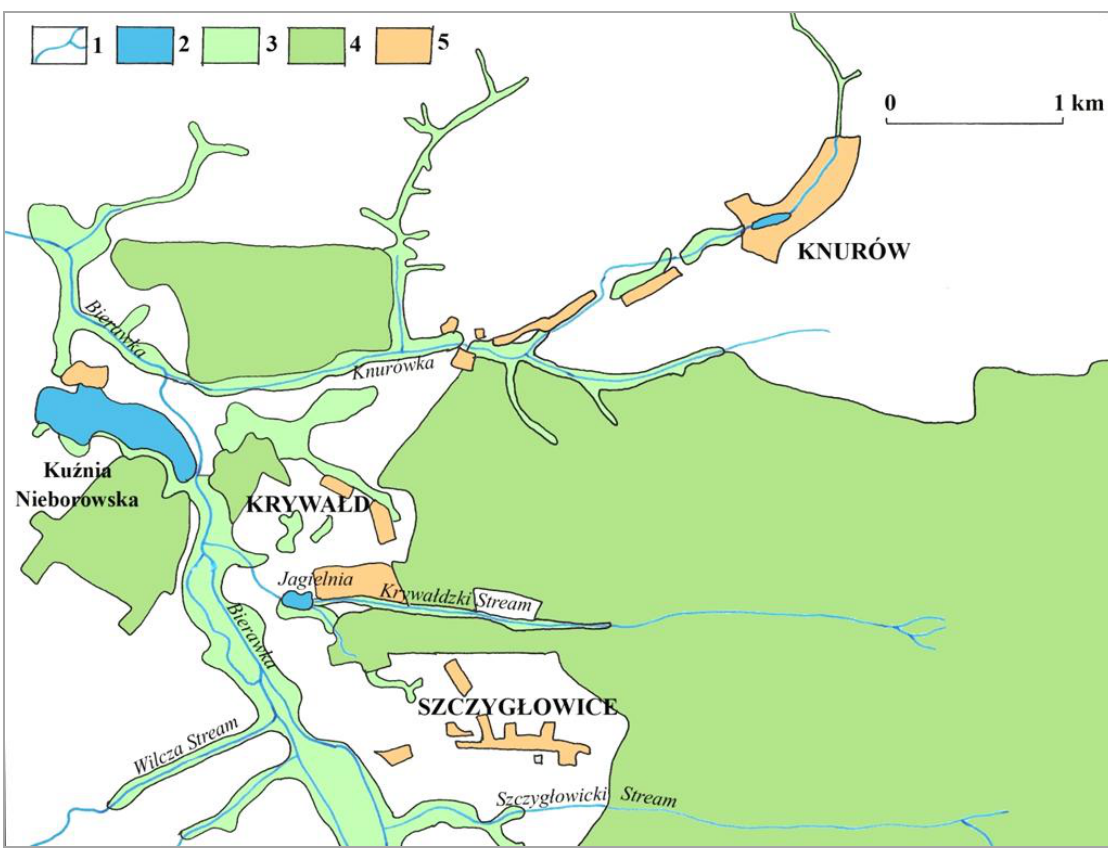
Fig. 1. Water reservoirs in the Knurów neighbourhood in